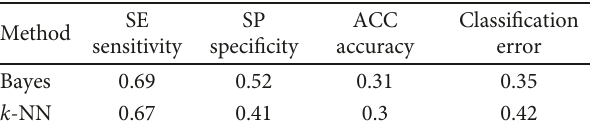
Table 2: Measures of rating classic methods.